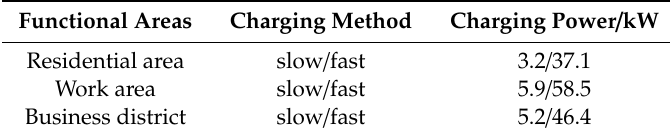
Table 1. Electric vehicle charging interface